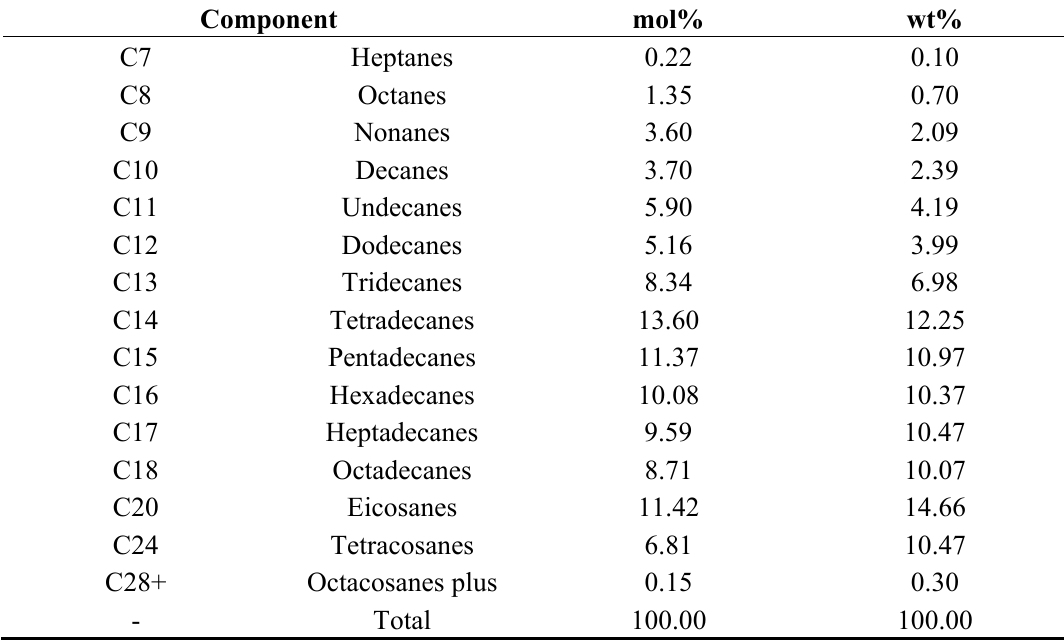
Table 1. Composition of the diesel oil used to form water-in-oil emulsion.